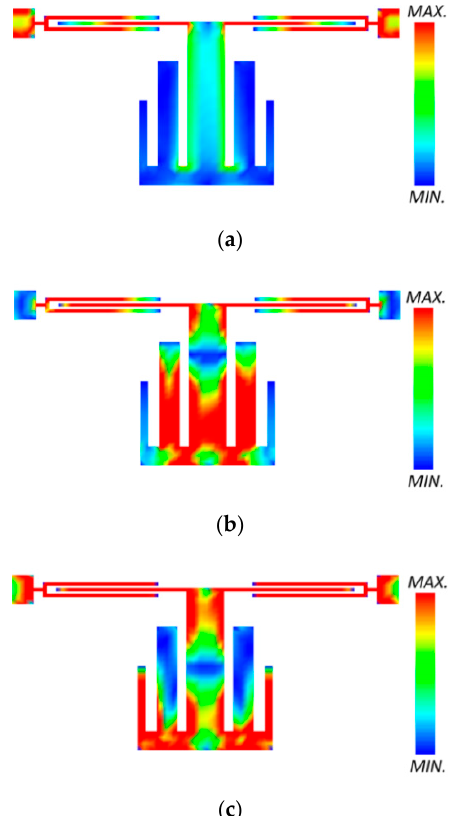
Figure 9. Current density distributions of the proposed BPF at different frequencies: ( a ) 1.76 GHz, ( b ) 9.68 GHz, ( c ) 11.5 GHz.